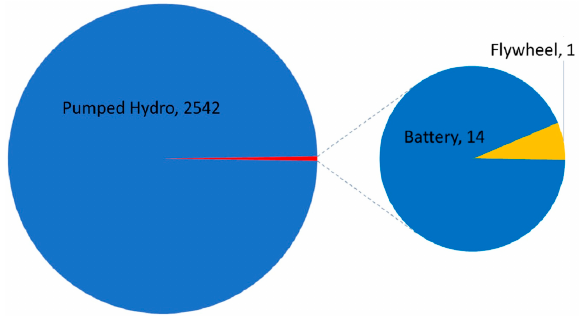
Figure 7. Australian energy storage capacity in MW (created from data obtained from [7,71]).